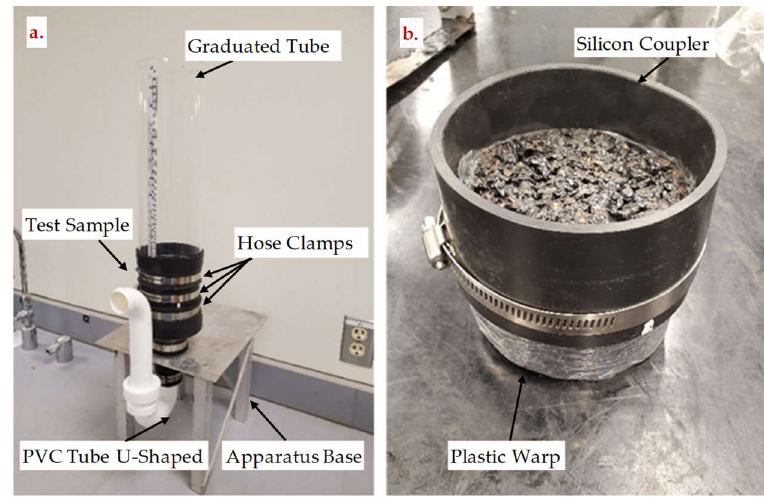
Figure 2. ( a ) Falling head permeability apparatus ( left ); ( b ) test sample preparation ( right ).